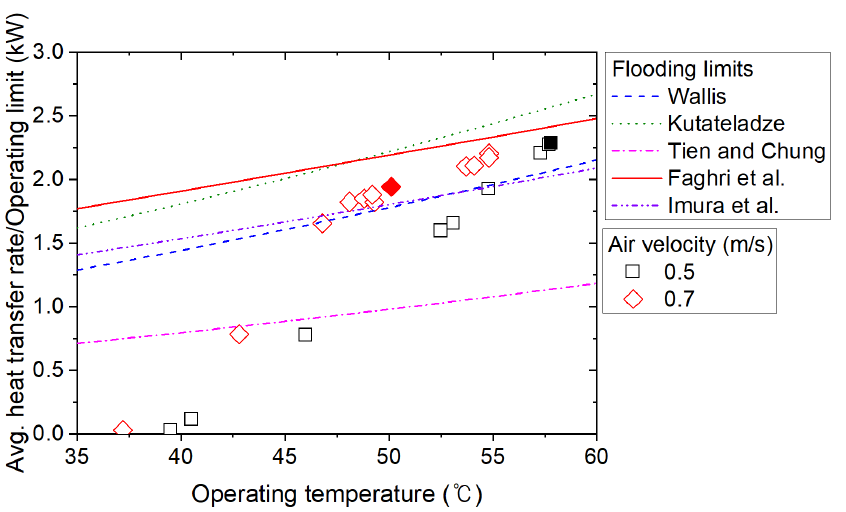
Figure 12. Comparison of flooding limits and experimental data. The filled symbols indicate the maximum loop conductance data.